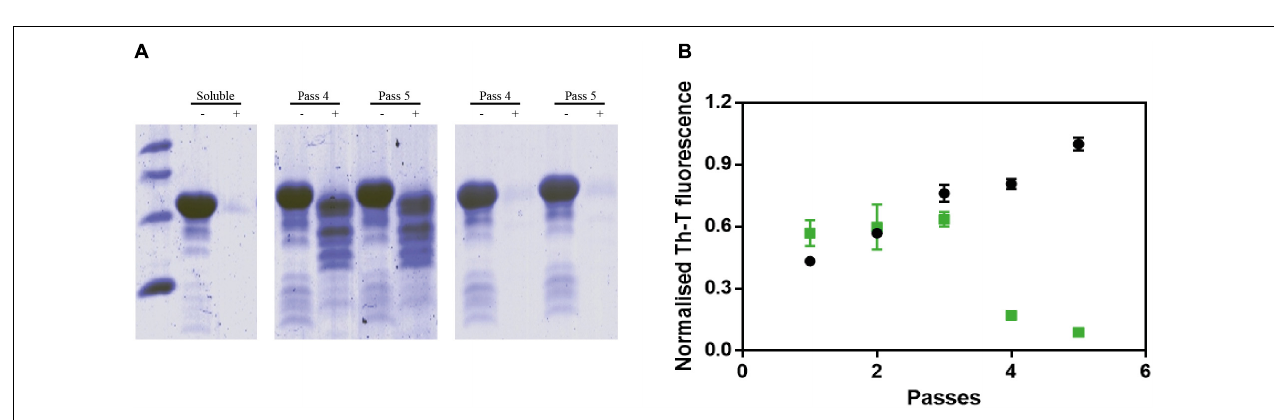
FIGURE 4 | ZPD-2 inhibits the aggregation of α -synuclein familial variants. (A) Aggregation kinetics of WT (black), H50Q (blue), and A30P (green) variants of α -Syn in presence (dotted) and absence (continuous) of ZPD-2, using Th-T as reporter. (B) End-point measurements of the aggregation of WT, H50Q, and A30P variants of α -Syn in presence (dotted) or absence (continuous) of ZPD-2 Th-T fluorescence are expressed as normalized means. Error bars are shown as standard errors of mean values.